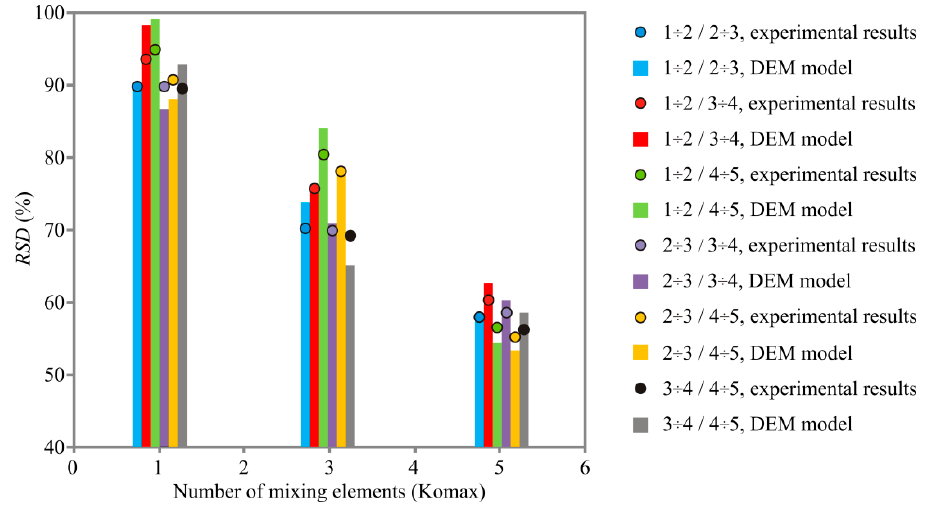
Figure 5. The RSD estimation for Experiment #1.